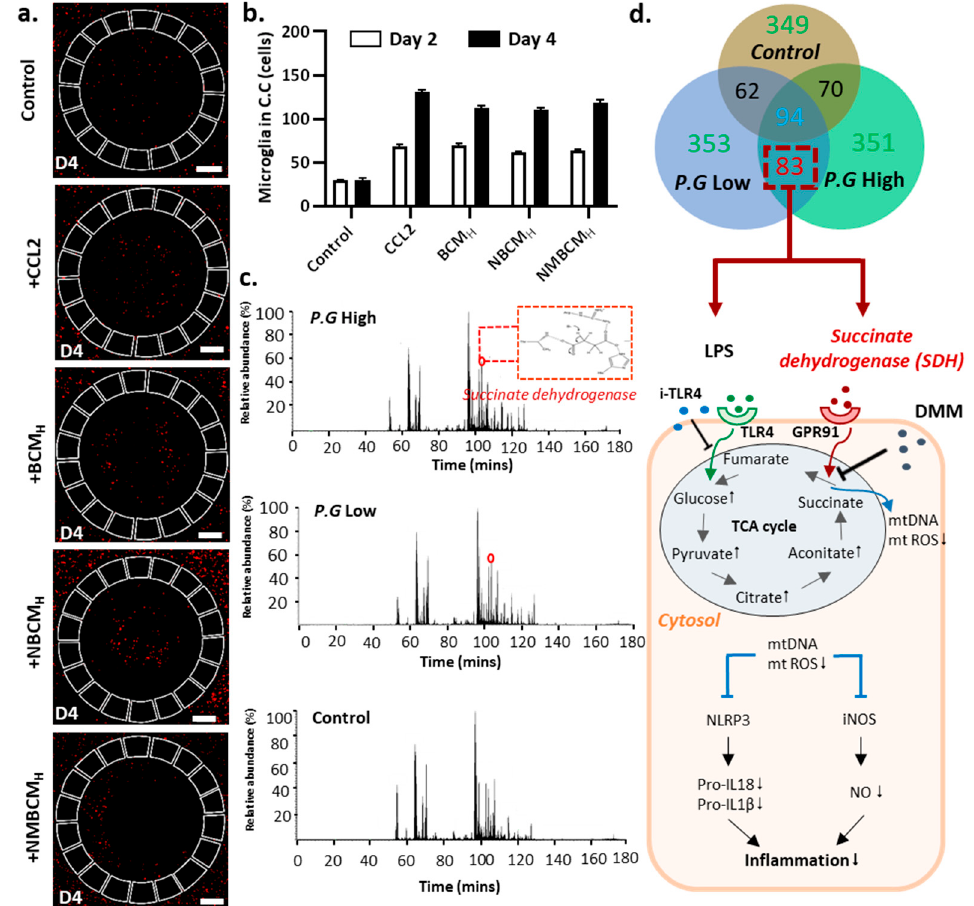
Figure 5. Microglial recruitment in microfluidic chip and investigation of new bacterial metabolites from the bacteria-conditioned medium. ( a ) Fluorescent images of microglial migration in brain-on- chip upon different mediators. ( b ) Quantification of recruited microglial cells into the central chamber at day 2 and day 4. ( c ) The results of liquid chromatography–mass spectrometry (LC-MS) analysis of bacterial conditioned medium (high and low concentrations) and control. ( d ) Total compounds found in three samples, high/low concentration BCM and medium. The proposed cellular mechanism of how the inhibition of succinate dehydrogenase could reduce neuroinflammation in microglia. All experiments were repeated three times independently and statistically analyzed by One-way ANOVA followed by Tukey HSD test (* p < 0.05, ** p < 0.01 and *** p < 0.001). All data were presented as mean ± standard deviation (SD).